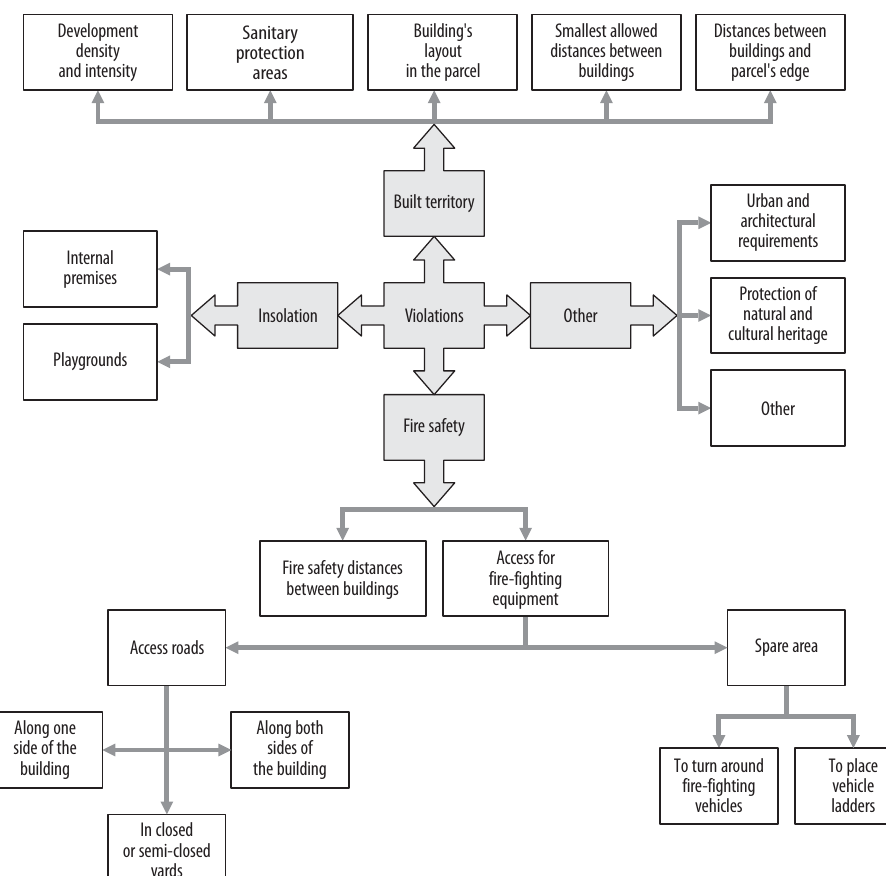
Figure 1. Classifi cation of possible violations of third party rights during territorial